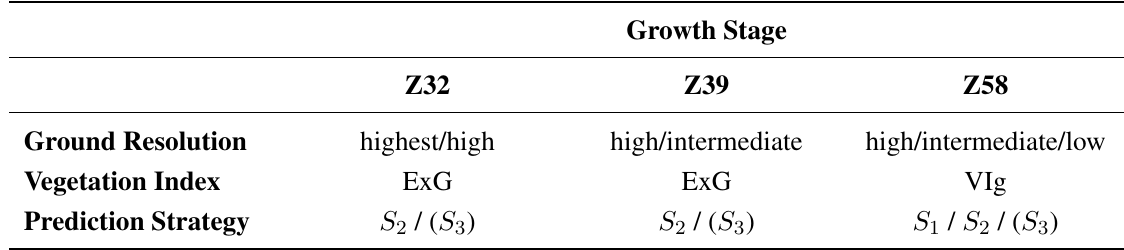
Table 7. Overview of the best performing parameters for early- to mid-season corn grain yield prediction at different crop growth stages. So far, the increase in prediction performance in strategy S appears to underlay an unknown factor. Therefore, strategy S is 3 3 listed in brackets. Growth Stage Z32 Z39 Z58 Ground Resolution highest/high high/intermediate high/intermediate/low Vegetation